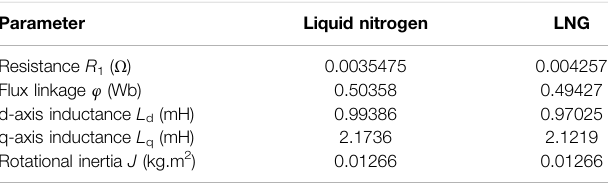
TABLE 2 | Simulation parameters of the prototype in liquid nitrogen ( − 196 ° C) and LNG ( − 161 ° C). Parameter